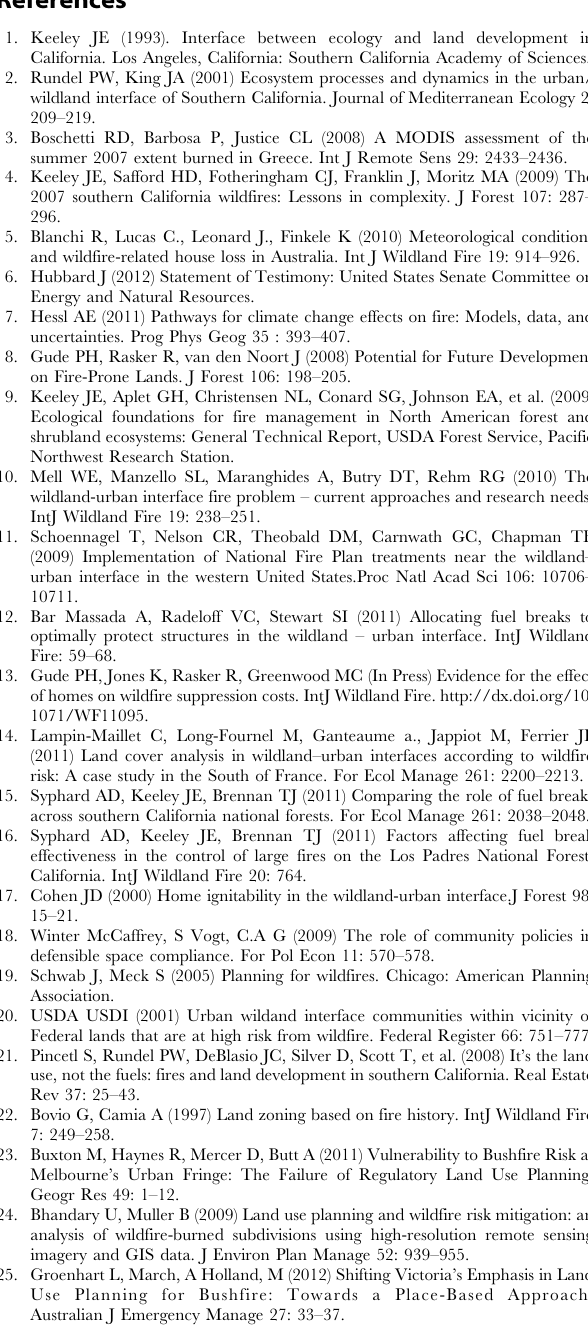
Table S1 Definitions and summary statistics for vari- ables used in the probit